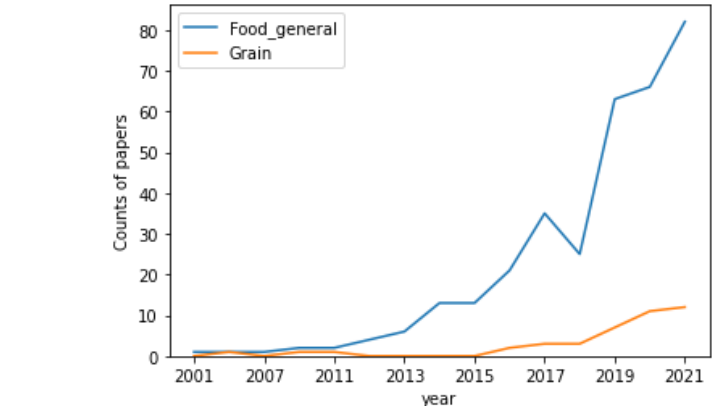
Figure 1. An overview of the published documents on cold plasma on food-related topics, pie chart: proportion of different types of publications; line graph: number of publications for 20 years (blue line: total and orange line: related to grain).